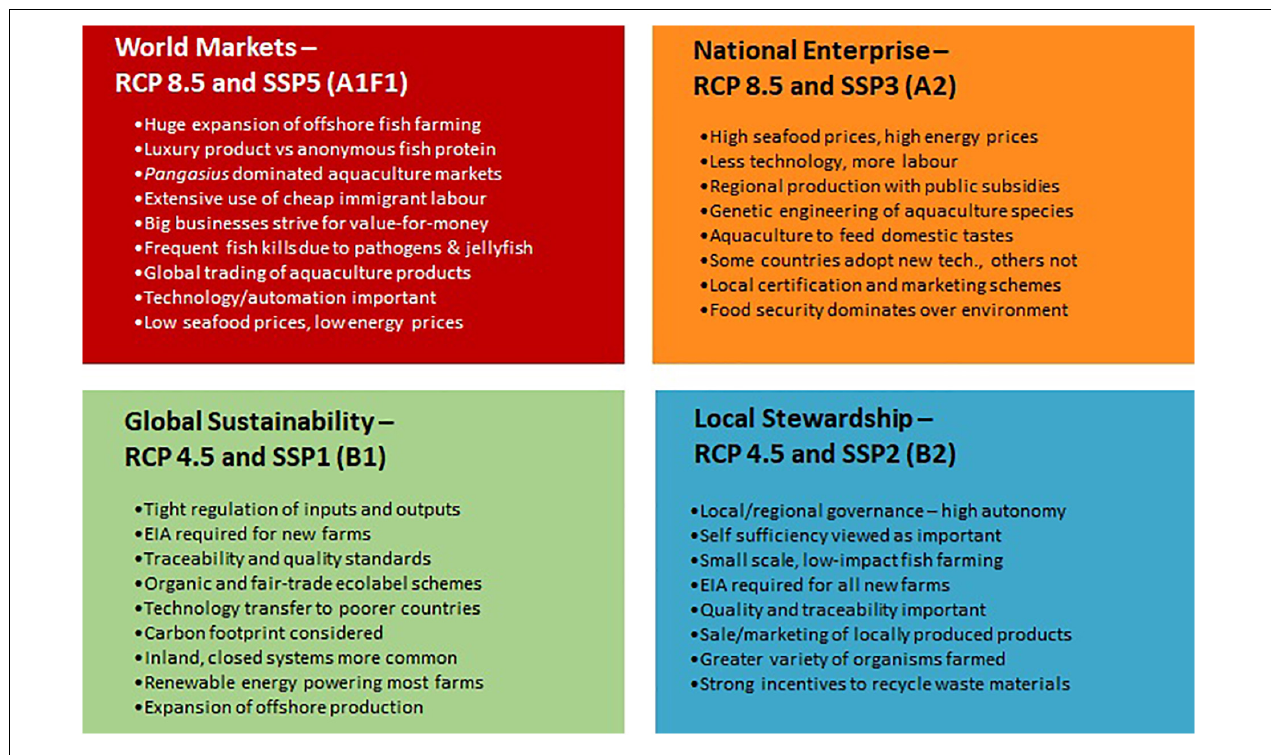
FIGURE 7 | Draft socio-political scenarios elaborated for European aquaculture by CERES partners and